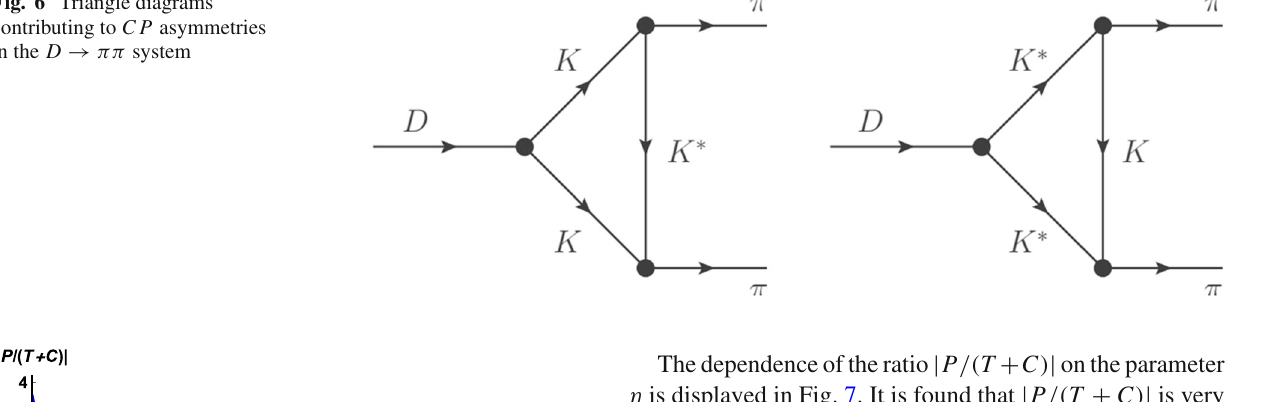
Fig. 6 Triangle diagrams contributing to CP asymmetries in the D → ππ system